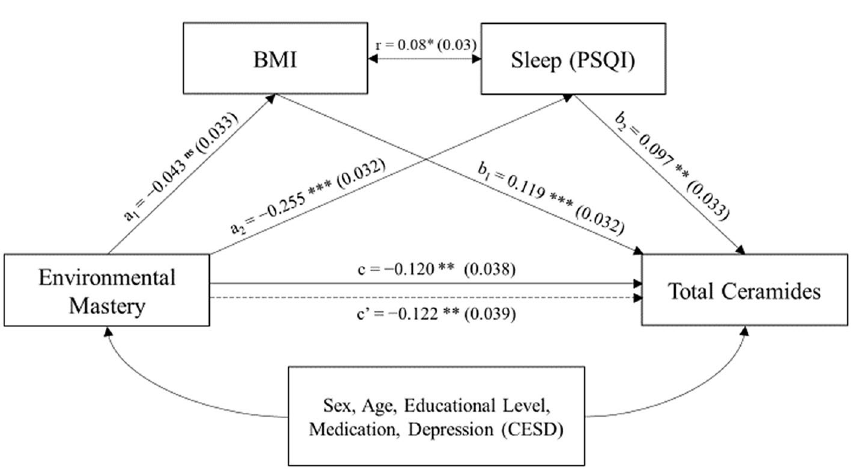
Figure 3. Mediation model of associations between environmental mastery and total ceramides, and possible mediation by sleep quality (PSQI) and BMI. Only participants with data for all variables were included, n = 913. Standardized regression coefficient and standard errors (in parentheses) of the multivariate linear regressions are presented. The paths affecting total ceramides (b and c) controlled for sex, age, educational level, depression (CESD), and medication usage (corticosteroids, cholesterol-lowering, antihypertensive and antidepressants). The direct path coefficient (c’) indicates the effect of environmental mastery on total ceramide levels adjusting for BMI and sleep quality, while the c path coefficient refers to the effect of environmental mastery on total ceramides without adjustments for mediators. The r value indicates Pearson correlation coefficient between BMI and sleep (PSQI). * p < 0.05, ** p < 0.01, *** p < 0.001. ns , not